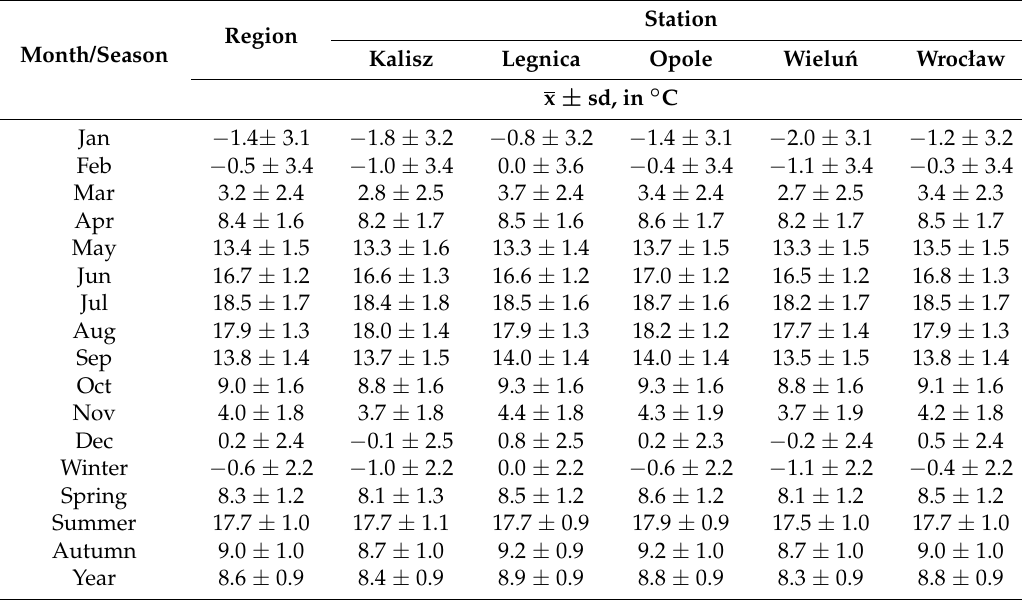
Table 3. Basic statistical characteristics (x ± sd, in ◦ C) calculated for air temperature (Ta),